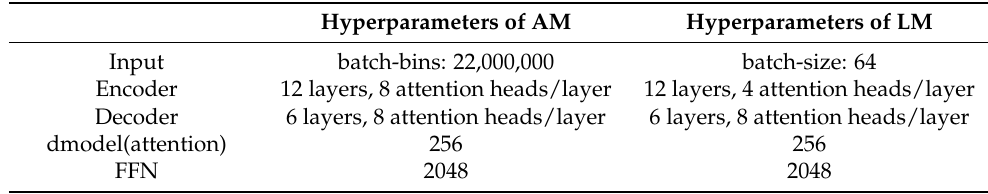
Table 4. Tuned hyperparameters for the acoustic modeling (AM) and language modeling (LM) transformers based on the grid search.